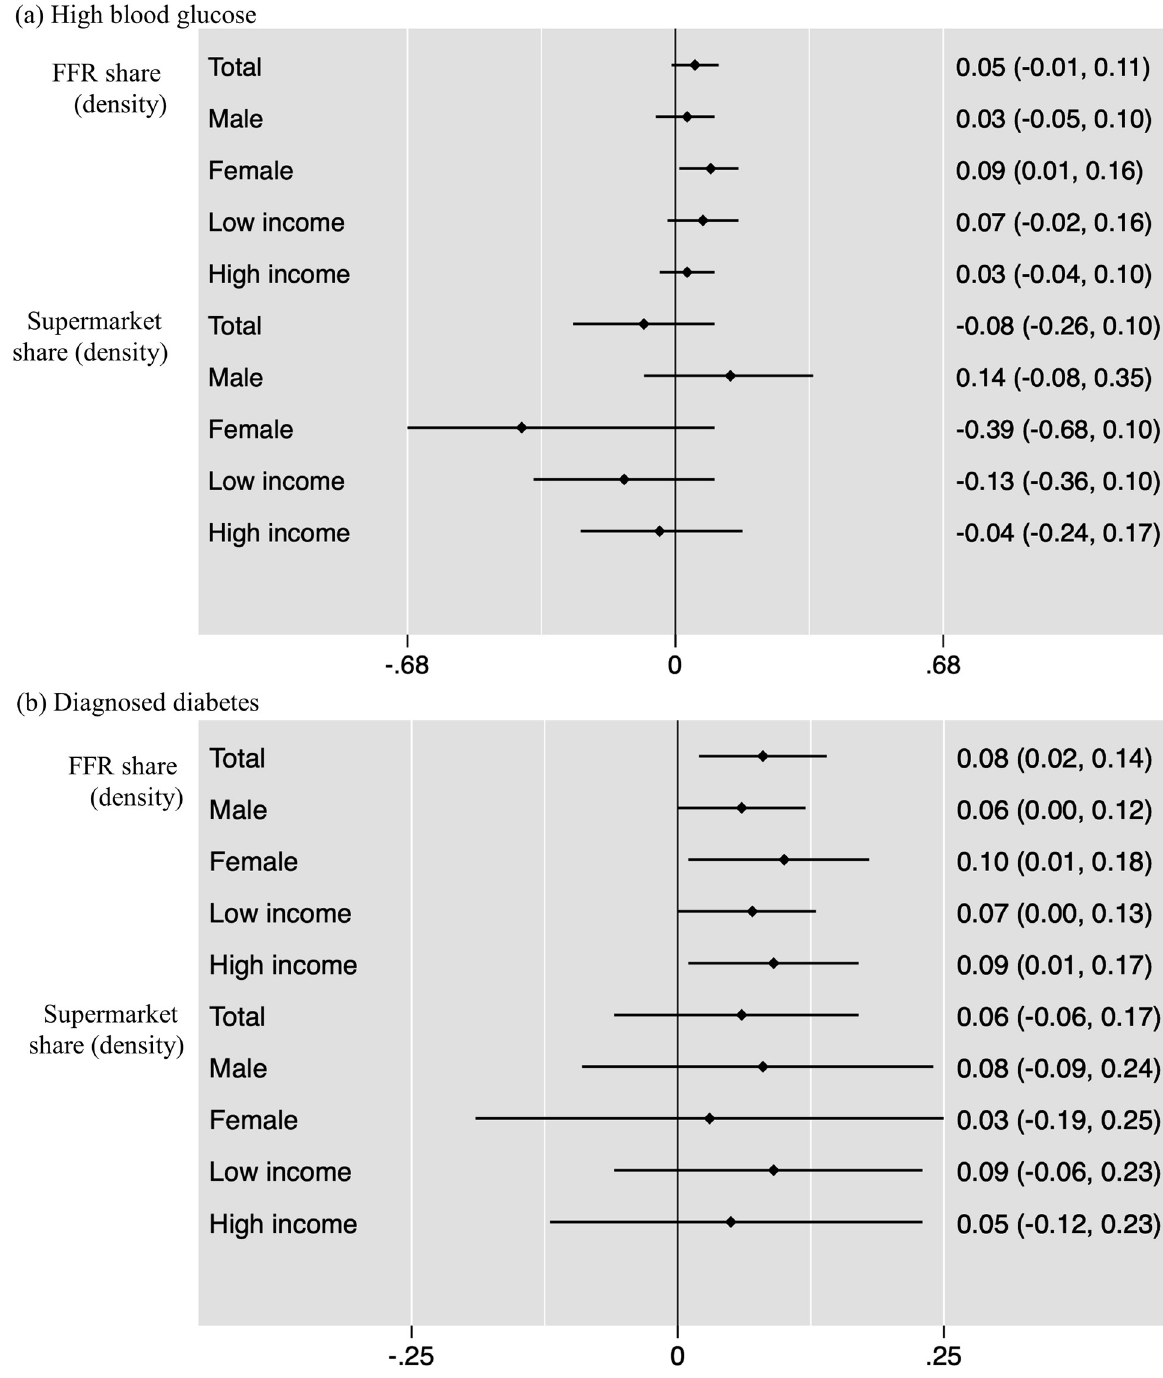
Fig 2. AMEs for the associations between diabetes mellitus and density food outlets. Note: The values show AME from logistic regressions in panels B and C; 95% CIs in brackets; horizontal bars = 95% CIs. Density = the number of each food outlet per total number of food outlets within 300 m of a resident’s home address. Proximity = 1 if having at least 1 outlet within 100 m of a resident’s home address and 0 if otherwise. AME, average marginal effect; FFR, fast-food restaurant.